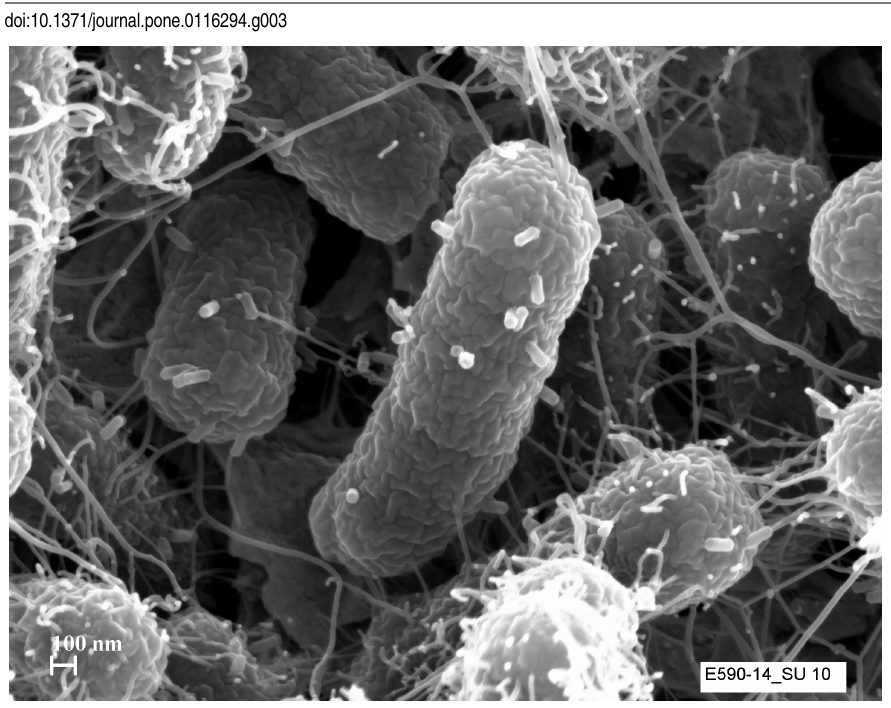
Fig. 3. Ultra-thin section electron microscopy SU10. Phage empty capsids are attached to the bacterial surface receptors and their genomes are injected to the host. Phage progenies heads are standing side by side in the bacterial cytoplasm and forming a honeycomb shape structure. Some of the heads are filled by genomes and some are in the stage of genome packaging.